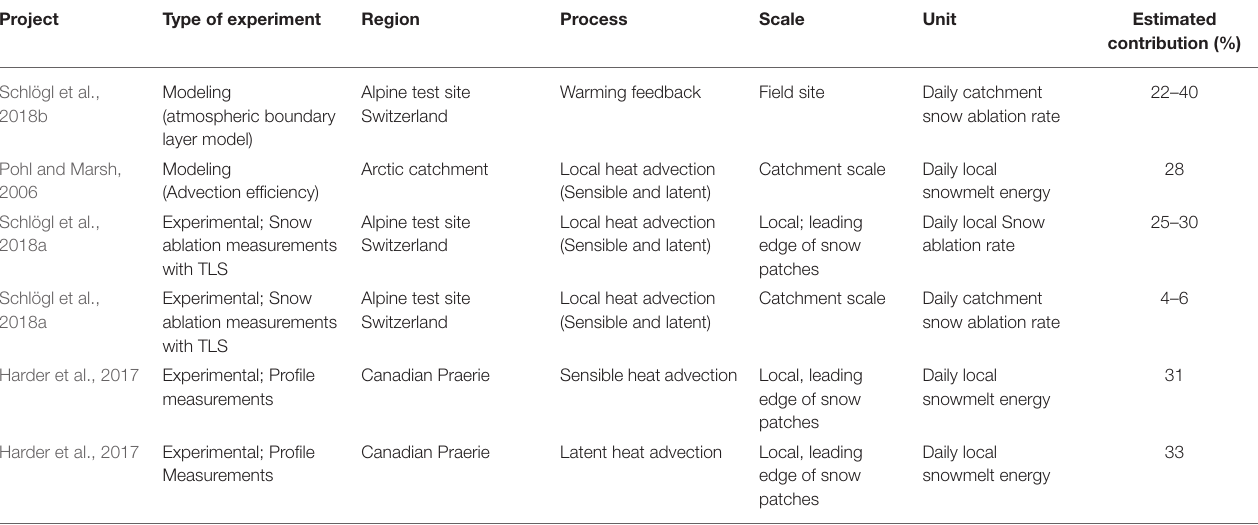
TABLE 4 | Comparison of estimated maximum contributions of local heat advection and warming feedback on snow melt rates or net available energy melt on the local scale (leading edge of snow patches) and on the catchments scale.